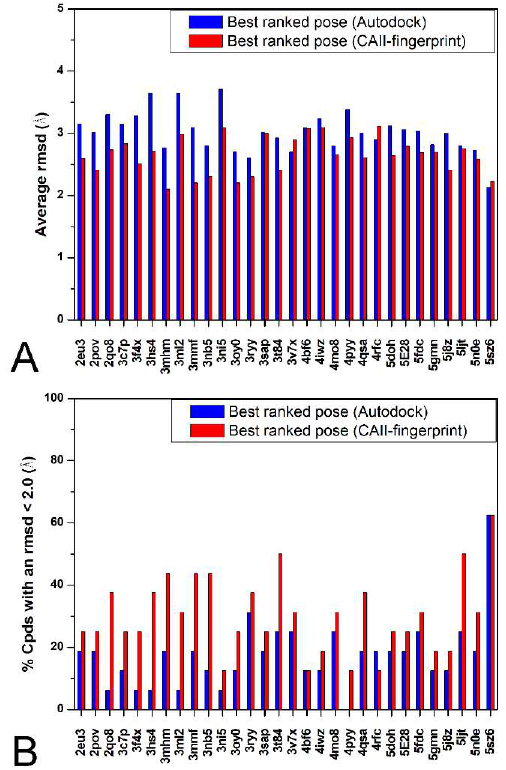
Figure 4. Comparison between the results obtained using the Autodock4 scoring function and the Tc-IFP for the second external test set. For each CAII protein, the aRMSD ( A ) and the percentage of poses with a RMSD less than 2.0 Å ( B ) are reported for both the best-ranked pose using the Autodock4 scoring function (blue) and using the Tc-IFP function (red).